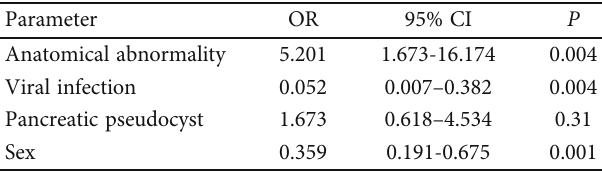
Table 2: The risk of acute recurrent pancreatitis